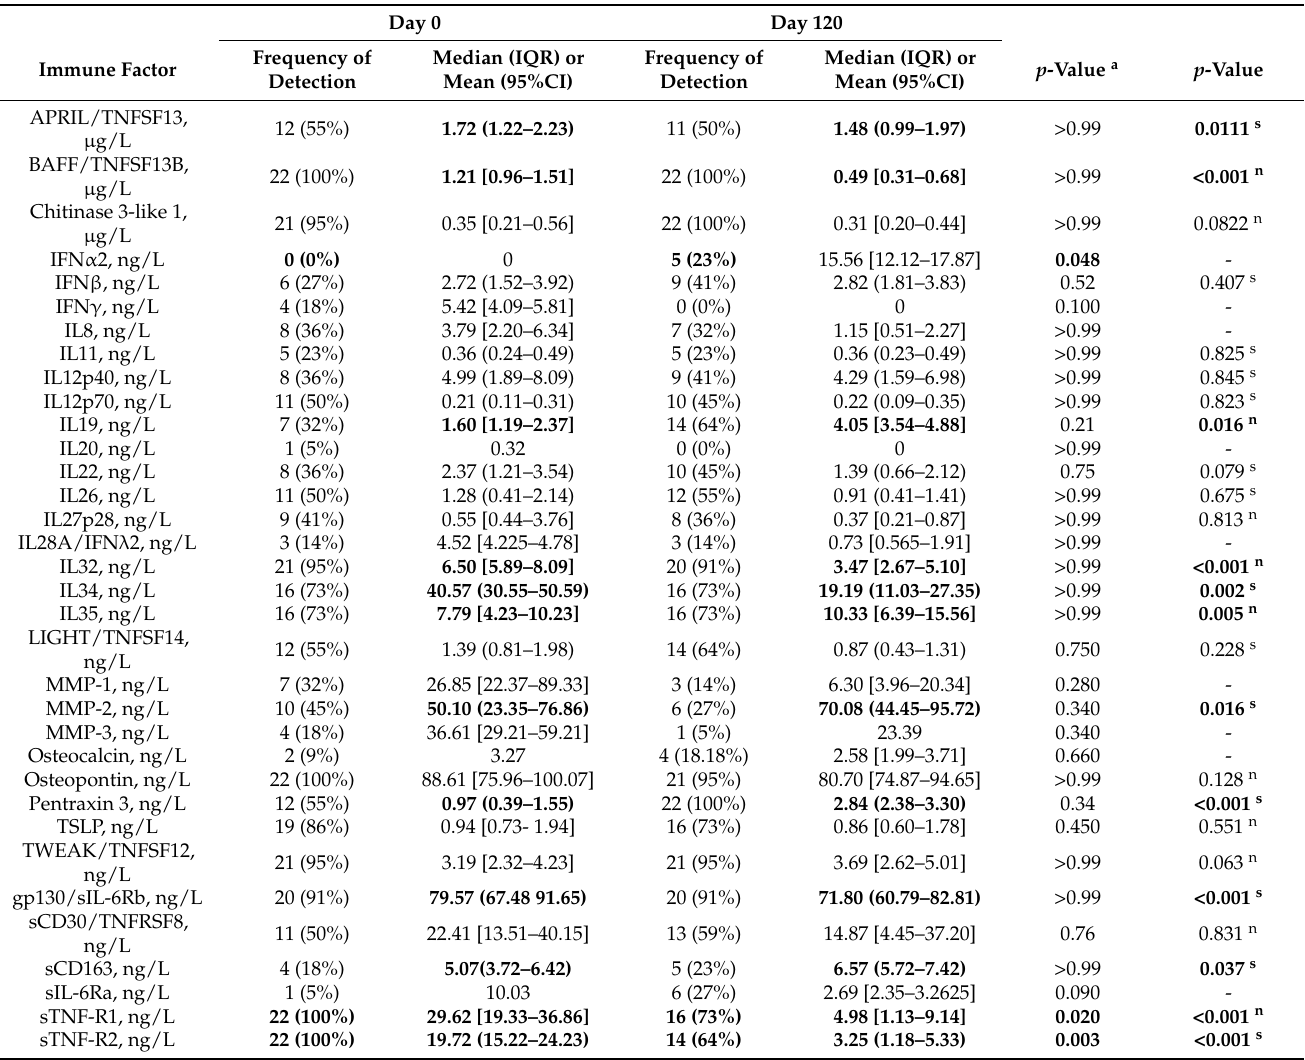
Table 4. Frequency of detection (%) and concentration of immune factors in fecal samples from the recruited participants before (day 0) and at the end (day 120) of the trial